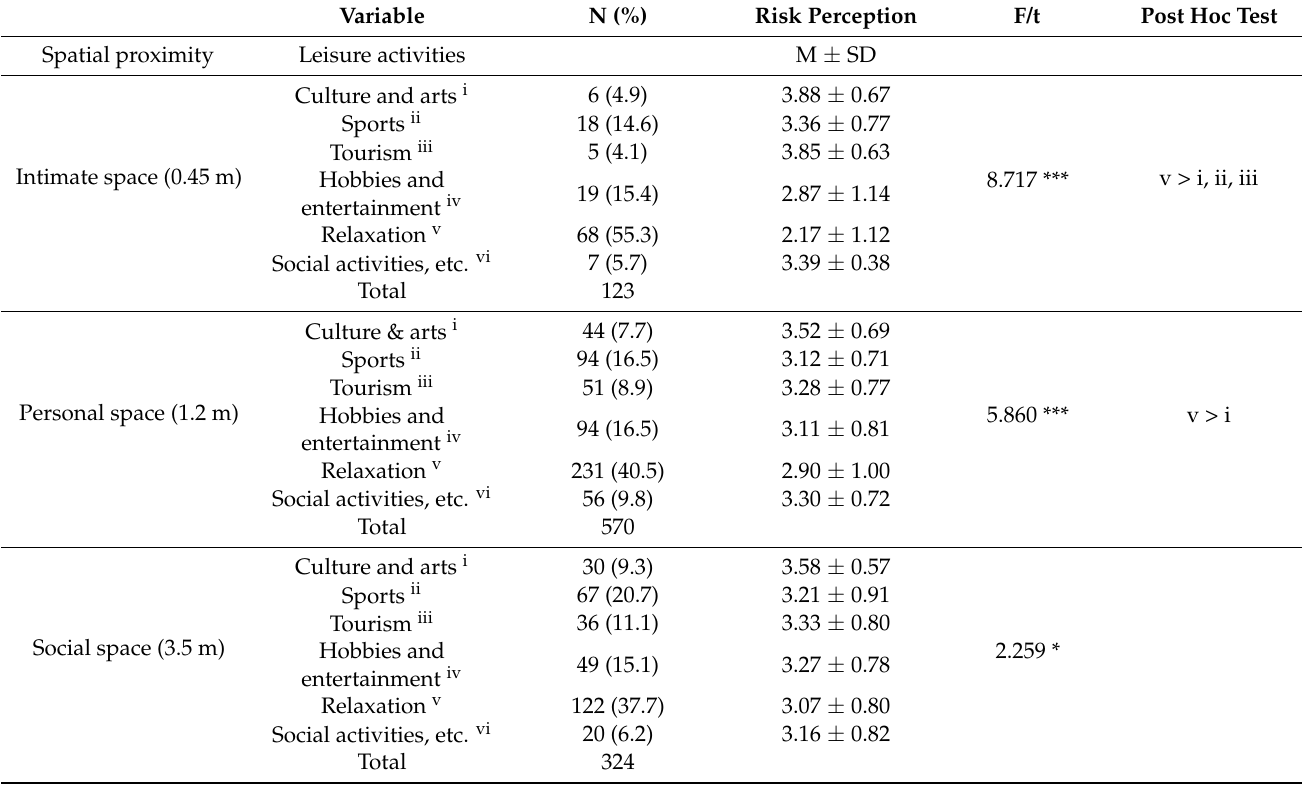
Table 3. Differences in Risk Perception According to the Leisure Activity Type in Different Spatial Proximity Zones (N =